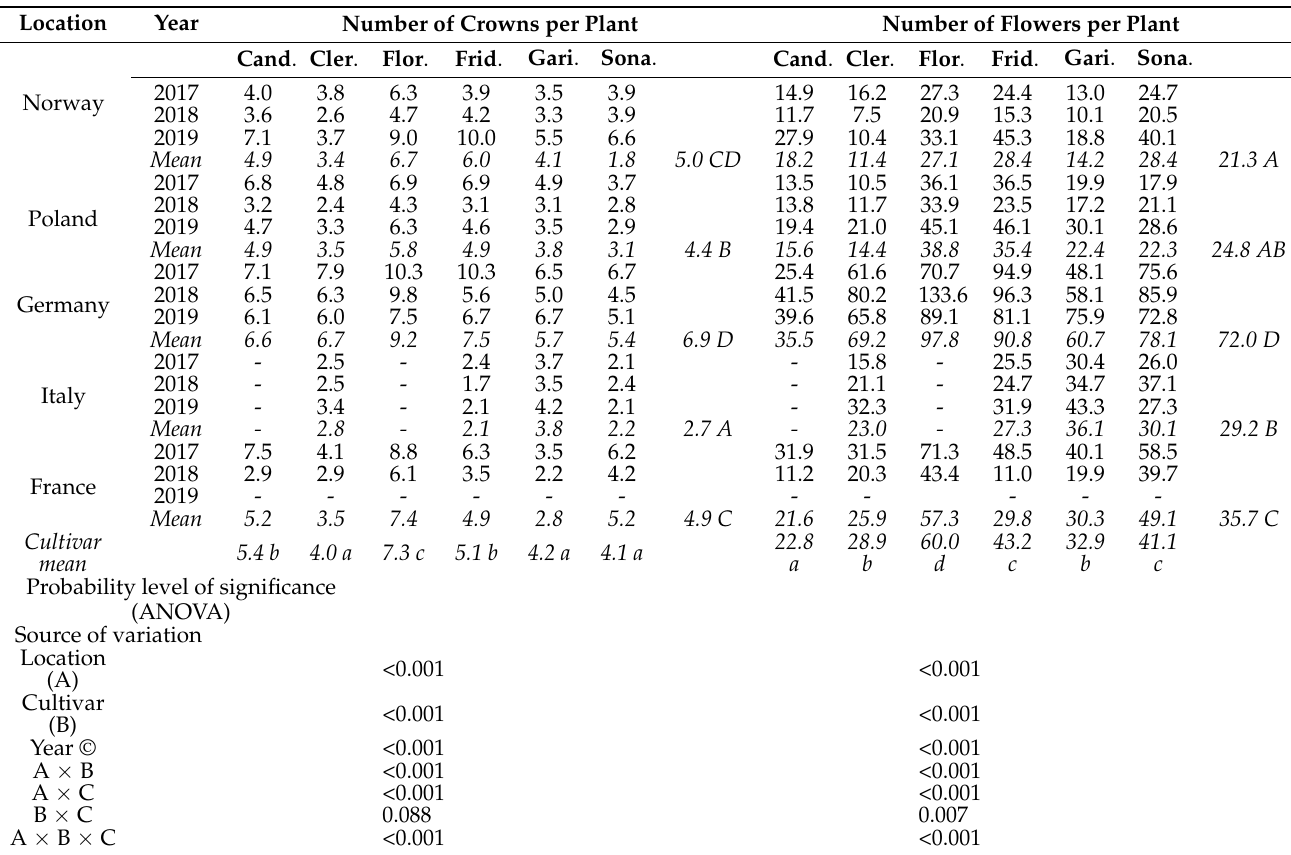
Table 3. Number of crowns and flowers per plant emerging in spring in six strawberry cultivars grown at five locations in